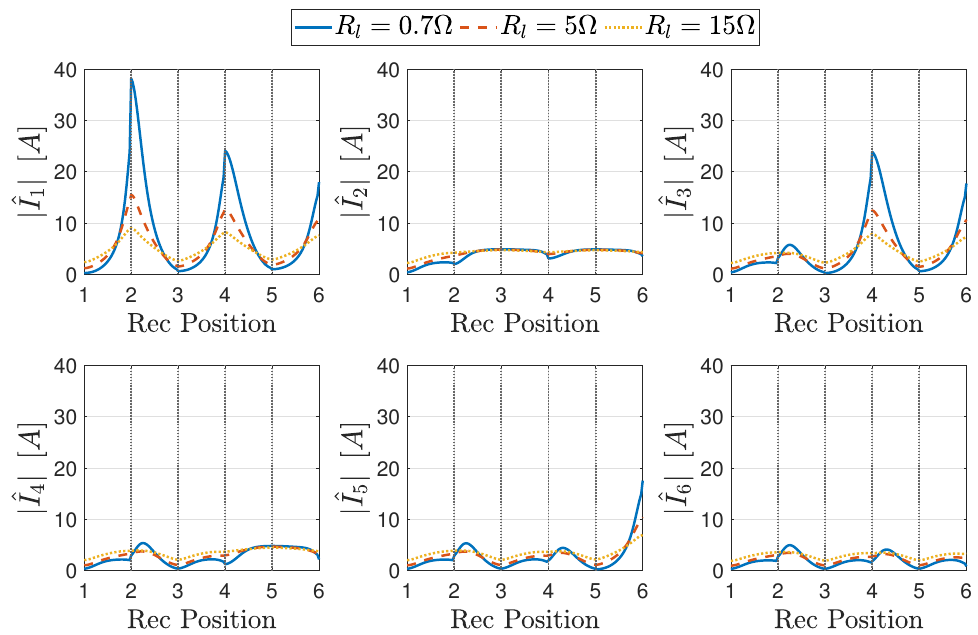
Figure 11. Current magnitude of each resonator as a function of the receiver position, for a matched array and different load